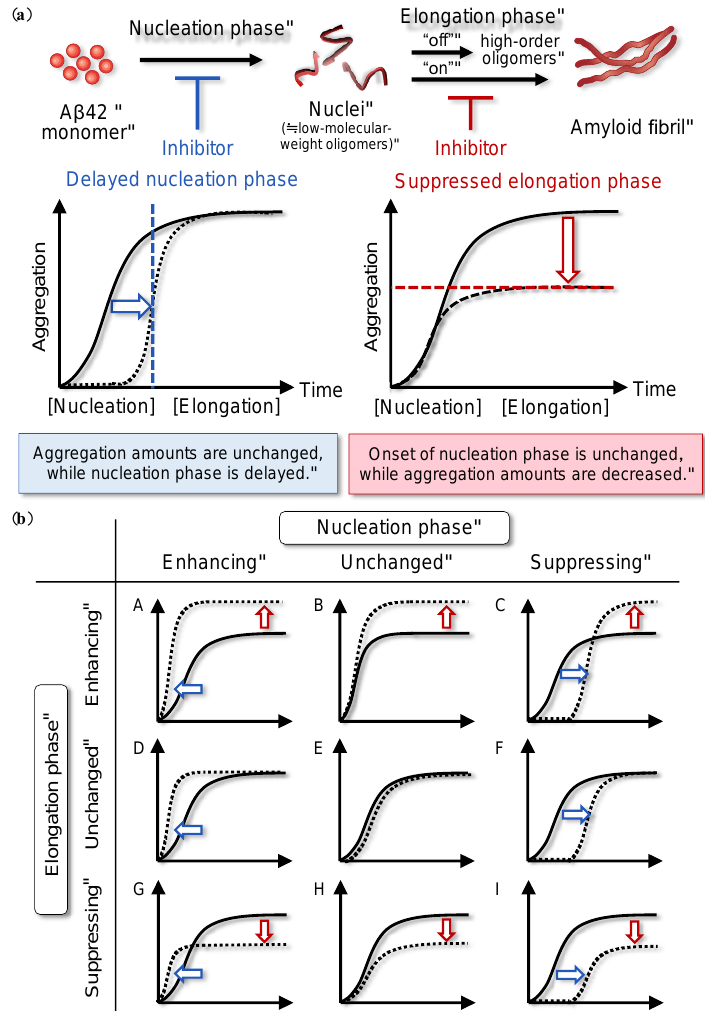
Figure 1. ( a ) Nucleation-dependent polymerization mechanism of amyloid β 42 (A β 42). The elongation phase is assumed to consist of “on”-pathway and “o ff ”-pathway into fibrillization. ( b ) Categorization of nine types of modulators of A β 42 aggregation focusing on the nucleation and elongation phases. In ( b ), only on-pathway route is indicated.